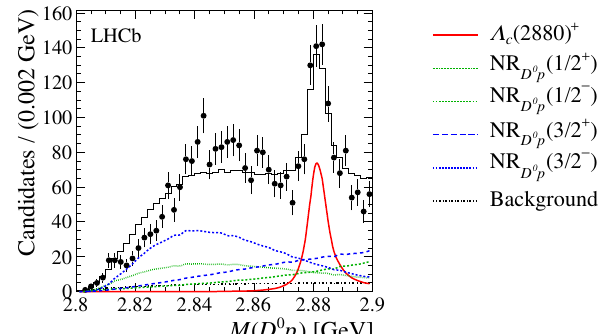
Figure 9 . M ( D 0 p ) projections for the (cid:12)t including the (cid:3) c (2880) + state and four exponential nonresonant